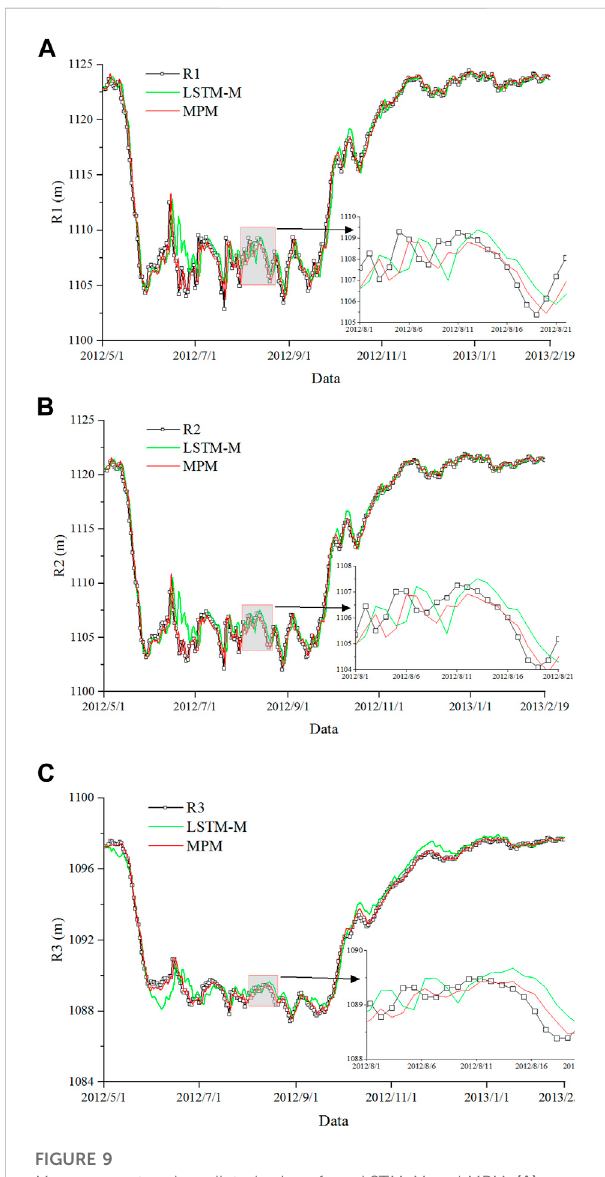
FIGURE 9 Measurement and predicted values from LSTM-M and MPM. (A) R1. (B) R2. (C)